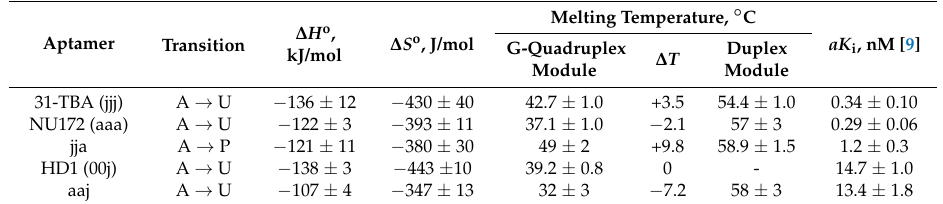
Table 3. Thermodynamic parameters of G-quadruplex modules of the aptamers with a single transition during thermal